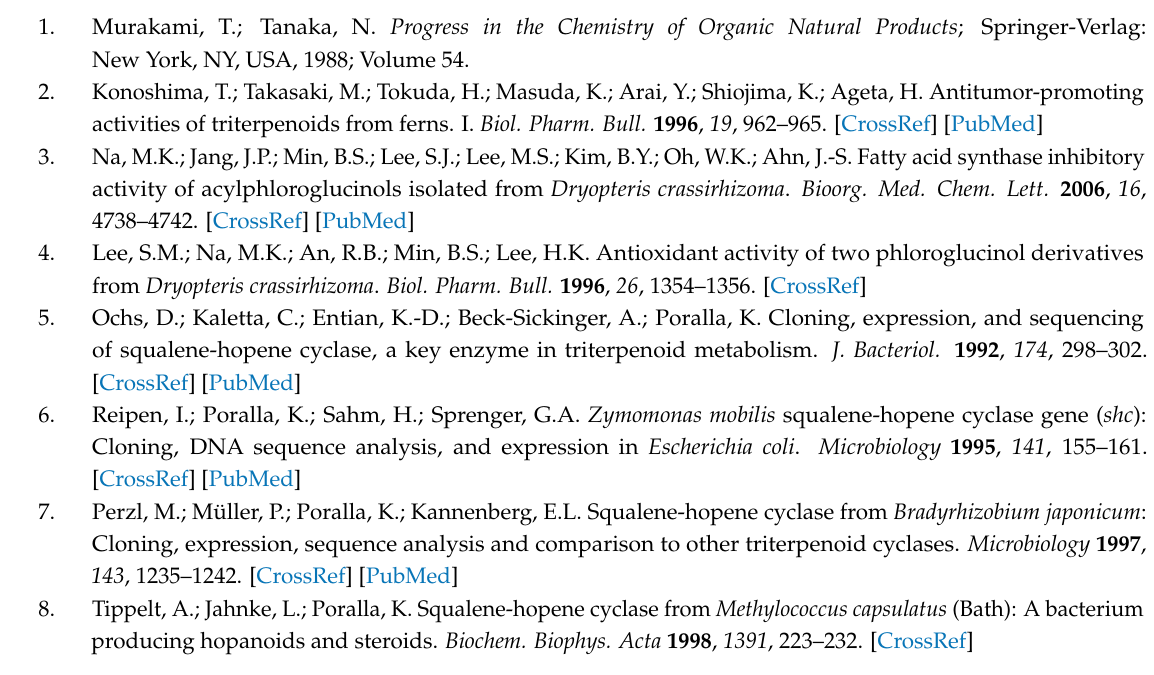
Supplementary Materials: The supplementary materials are available online; Figure S1: Phylogenetic tree of triterpene synthases, Figure S2: Amino acid sequence alignment of PPH and hydroxyhopane and hopene synthases from ferns and a bacterium, Figure S3: Phylogenetic tree of CAS clade (A) and fern SC clade (B), Table S1: Sequence information used in the phylogenetic